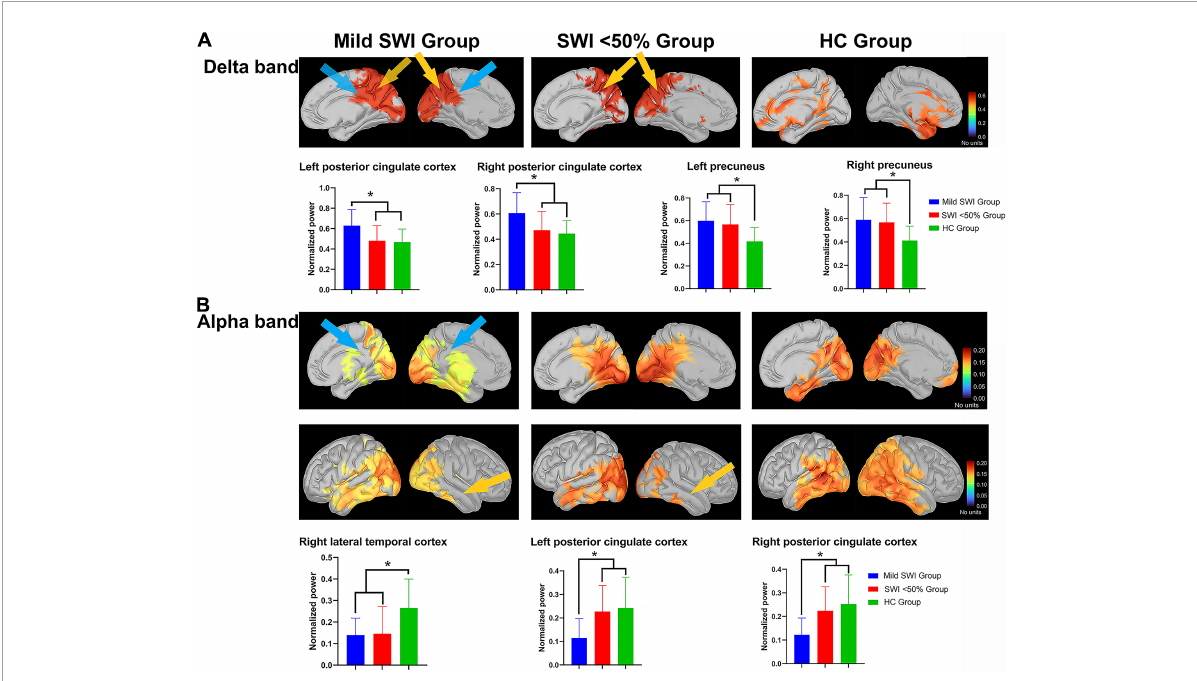
FIGURE1 The significant differences regarding spectral power between the mild SWI group, SWI < 50% group and HC group. The blue arrows represent that the mild SWI group is significantly different from the other two groups, and the yellow arrows represent that both the mild SWI group and the SWI < 50% group were significantly different from the HC group. In the delta band (A) , the mild SWI group had significantly enhanced spectral power within the bilateral PCCs, and both the mild SWI group and SWI < 50% group had significantly enhanced spectral power in the bilateral PCu. In the alpha band (B) , the spectral power of the right LTC was significantly attenuated in both the mild SWI group and SWI < 50% group, and the spectral power of the bilateral PCCs in the mild SWI group was significantly attenuated. * P -values after correction were less than